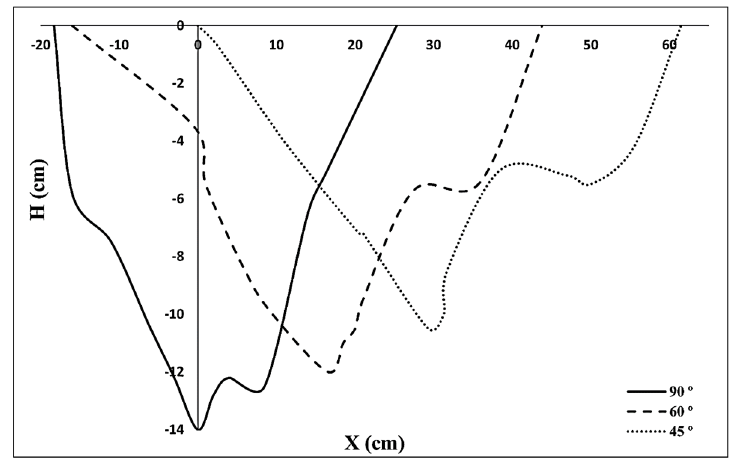
Figure 13. Scour hole profiles around the dike with different orientation angles (water depth: 11 cm, open channel flow). Scour hole measurements subject to +/- 0.03 cm error.